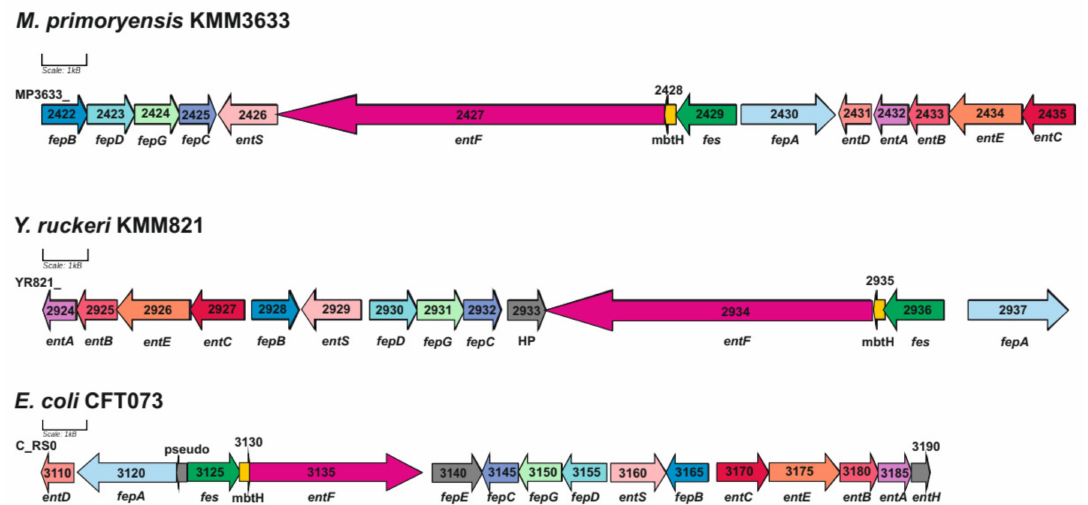
Figure 2. Genetic organization of the Y. ruckeri KMM821 ruckerbactin biosynthetic uptake cluster compared to the M. primoryensis KMM3633 T and E. coli CFT073 enterobactin gene clusters. entA